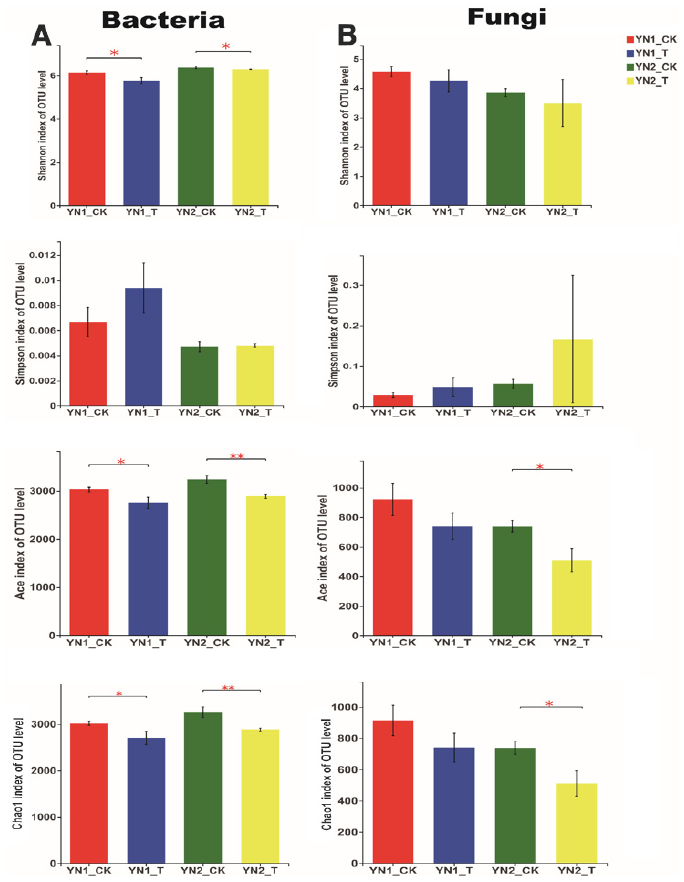
Figure 4. Chao1, ACE, Shannon and Simpson indices showing taxonomic changes in ( A ) bacteria and ( B ) fungi in triple-fumigated soil types (YN1 and YN2) that had been used to produce ginseng. ‘Triple fumigation’ refers to the simultaneous application of chloropicrin, dimethyl disulfide and metham sodium. The t- test reported the statistical differences (asterisked, * 0.01 < p ≤ 0.05; ** 0.001 < p ≤ 0.01.) between the means of three replicates within each graph.